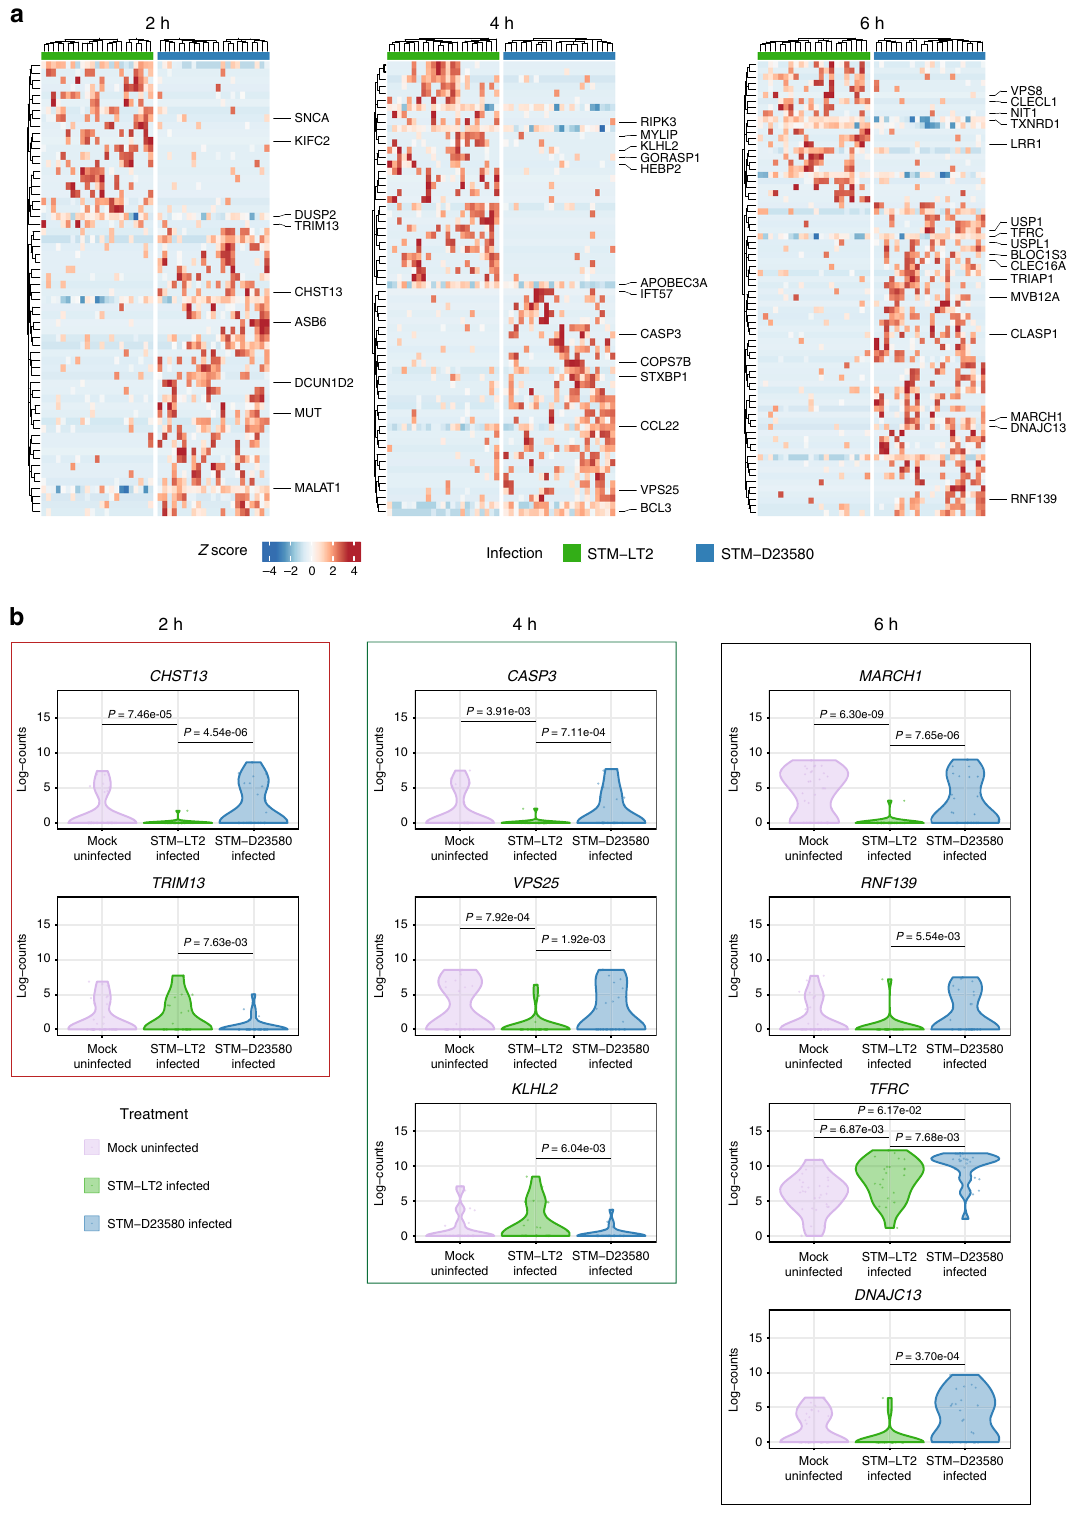
Fig. 5 Direct comparison of MoDCs infected with STM-D23580 or STM-LT2. a Heat maps displaying signi fi cant DE genes ( P -value < 0.01) identi fi ed between STM-D23580 and STM-LT2-infected cells at each time point (2, 4 and 6 h p.i, respectively). Rows and columns were clustered using Euclidian distance and complete linkage method applied to the row-scaled values across all heat map panels at that time point. b Violin plots displaying the log- transformed normalized gene expression level of relevant DE genes ( P -value < 0.01) identi fi ed between STM-D23580- and STM-LT2-infected